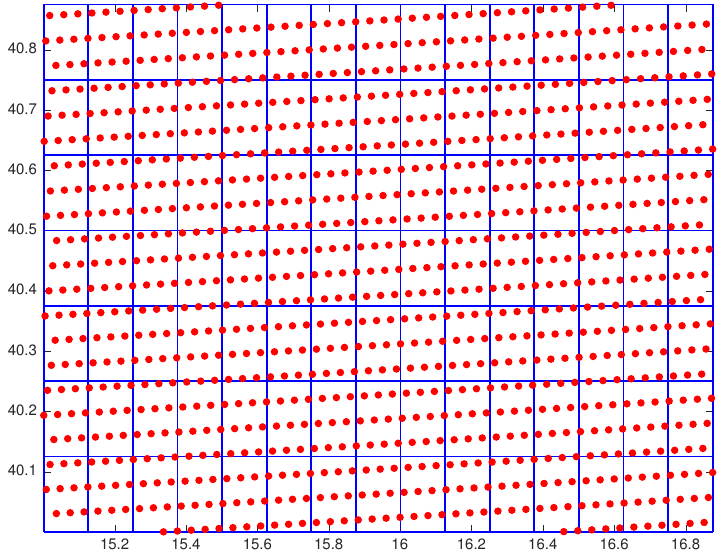
Figure 2. Overlapping between the SEVIRI mesh and that coarser corresponding to the ECMWF analysis on a zoom of the target